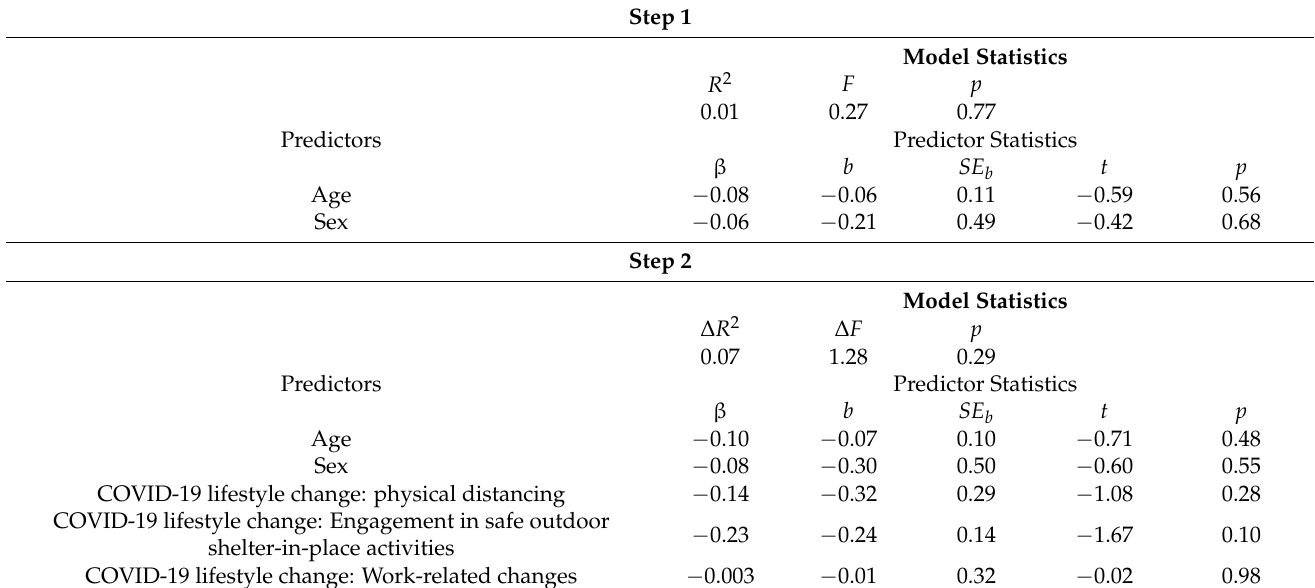
Table 3. Hierarchical regression predicting boredom